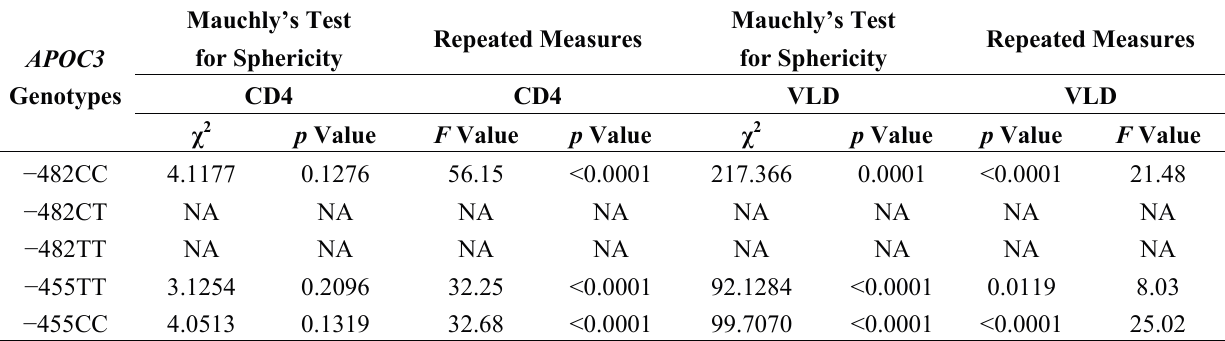
Table 1. Repeated measures of analysis of APOC3 genotypes of study participants with CD4 and viral load parameters. A p value of <0.05 was considered significant. Values are only for 53 patients for whom viral load and CD4 + cell count measurements were available. No analysis was done for APOC3 − 482CT and TT genotypes as very few individuals were identified with these genotypes. χ 2 value indicates the difference between expected and observed genotype frequencies